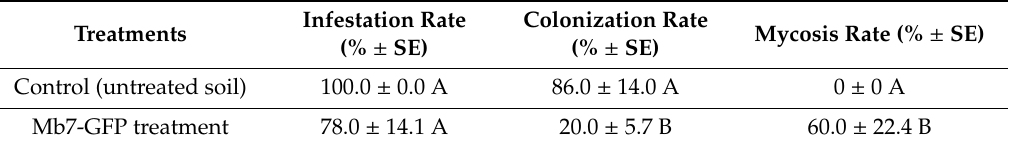
Table 2. Infestation, colonization, and mycosis rates of C. tenebrionis larvae in untreated soil (control) and Mb7-GFP treatment (5 × 10 6 conidia / g